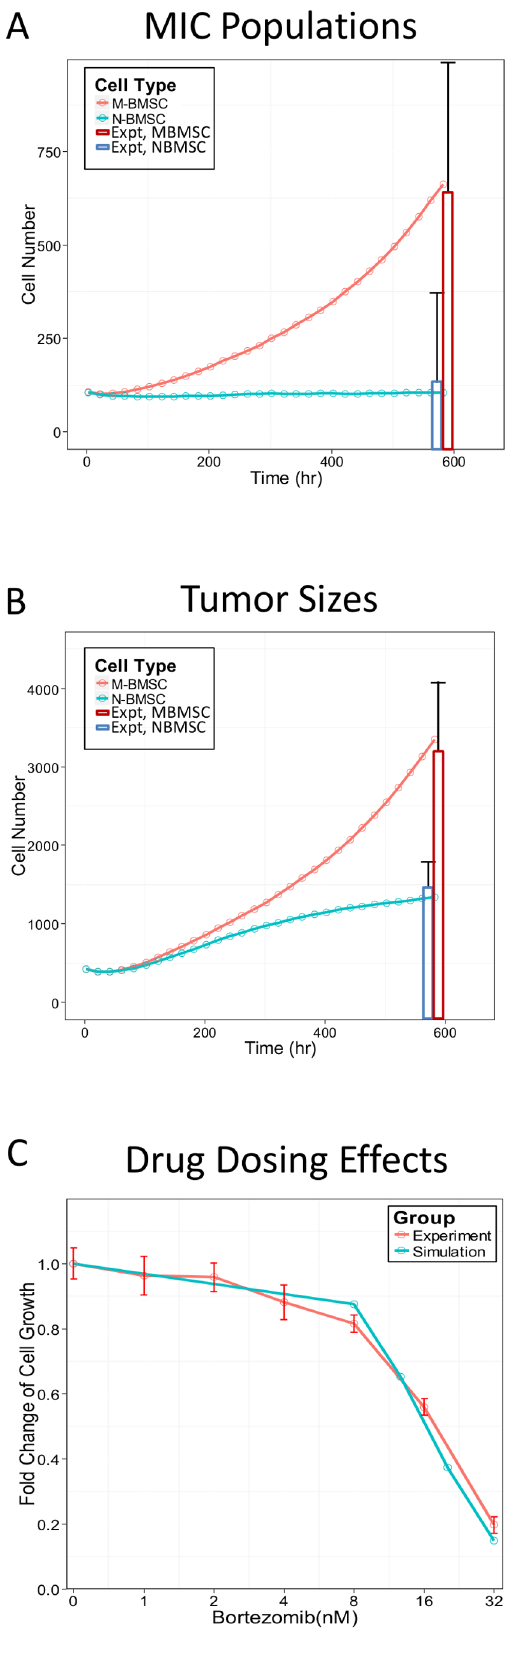
Figure 3. Comparison of simulation results and experiment observations. The simulation results of the MIC populations (A) [18] and the total tumor sizes (B) [18] under NBMSC or MBMSC environments as well as the dose responses in terms of total tumor size decrease (C) [36] were compared with our published experiment